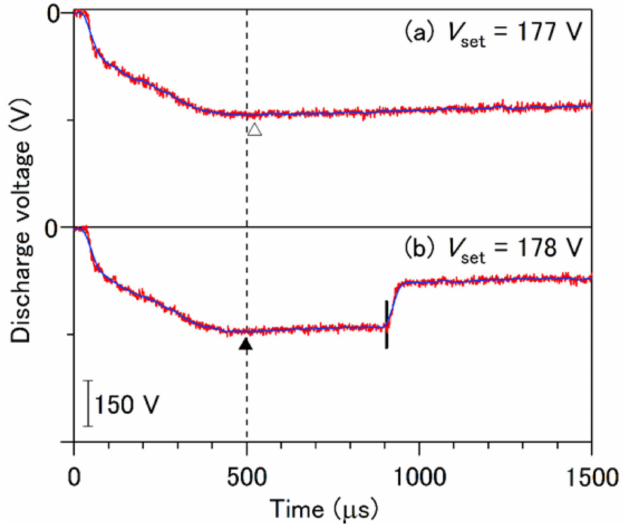
Figure 5. Voltage waveforms measured to determine values of V s in MPPMS discharged for two different values of V set at a working pressure of 1.55 Pa. The black dashed line indicates the cutoff time of pulsed power, which is output from the high-power pulsed generator. ( a ) Maximum voltage waveform with no observed discharge at V set = 177 V. The blue lines on the voltage waveforms depicted by red lines are the smoothed voltage waveforms for reading the maximum voltages. The open triangle represents the maximum charge voltage in the voltage waveform. ( b ) Minimum voltage waveform with observed discharge at V set = 178 V. The solid triangle represents the maximum charge voltage in the voltage waveform. The short black line indicates the time of electrical breakdown occurring after the cutoff time of pulsed power. The value of V s is approximately determined as the average of the voltages indicated by the two triangles. The resulting V s obtained in the present study show a small change as a function of pressure as compared to the calculated values [41].